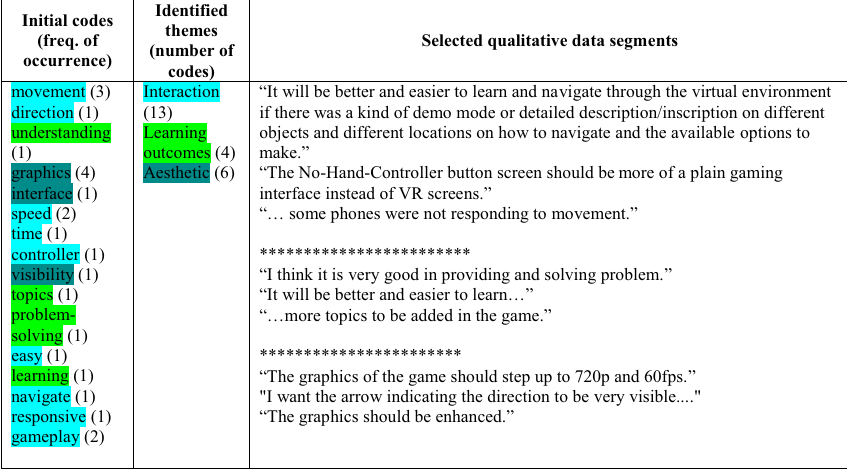
Table 6 Thematic analysis of participants’ brief qualitative data regarding their experience using the IVR application Initial codes (freq.